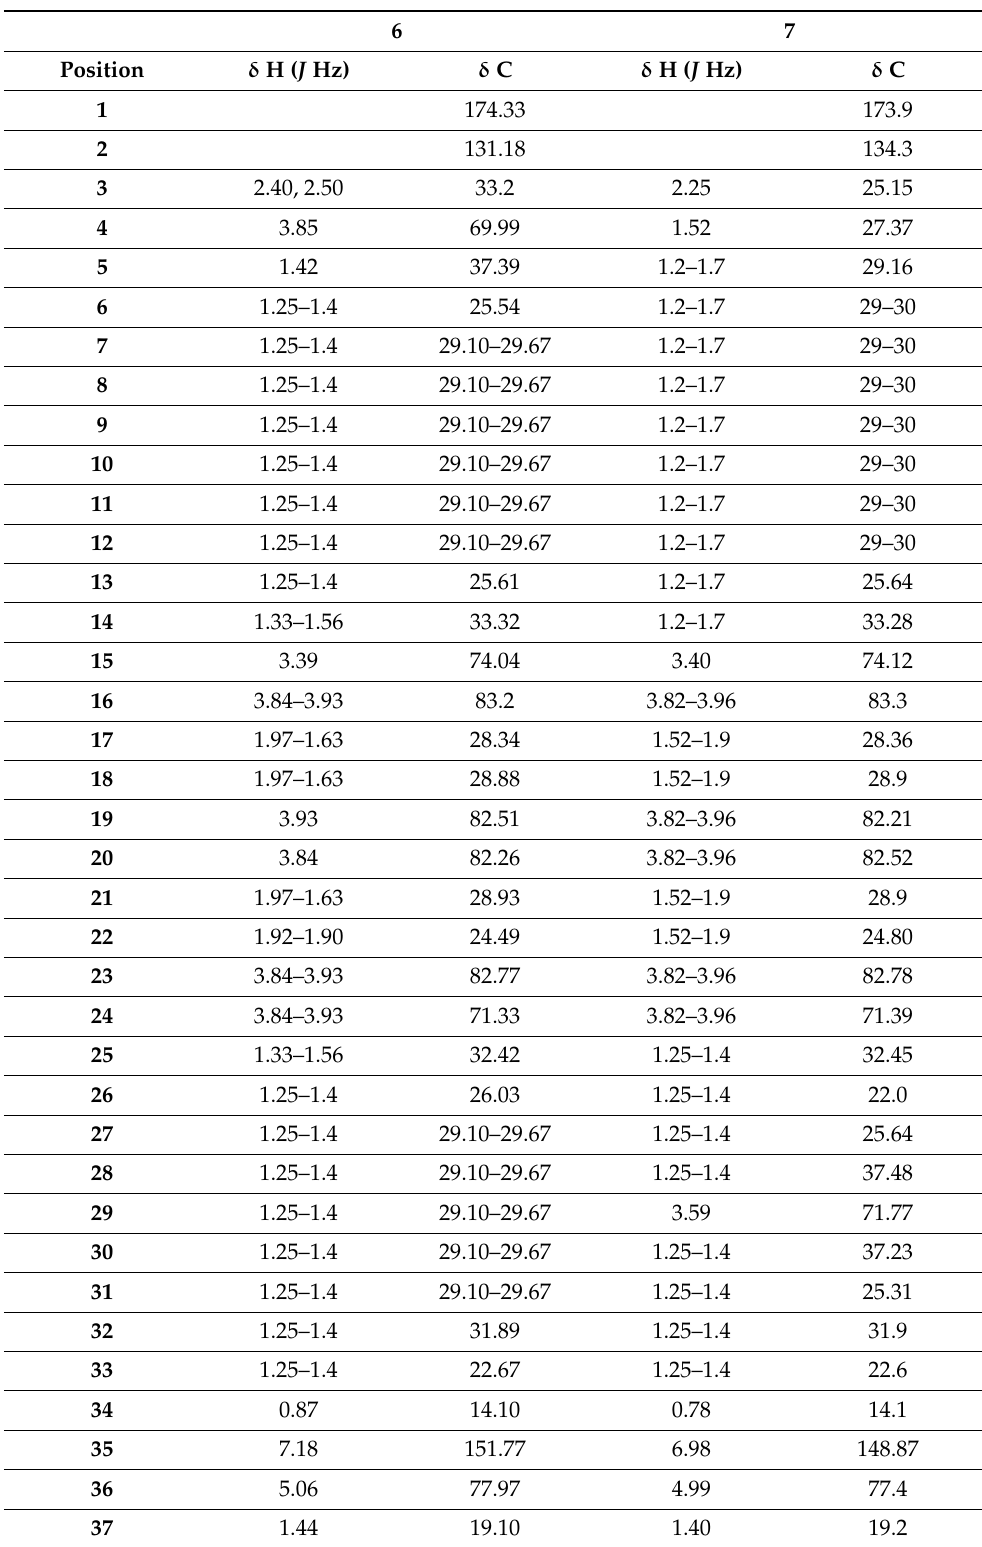
Table 1. 1 H and 13 C NMR data for compounds 6 and 7 recorded in CDCl 3